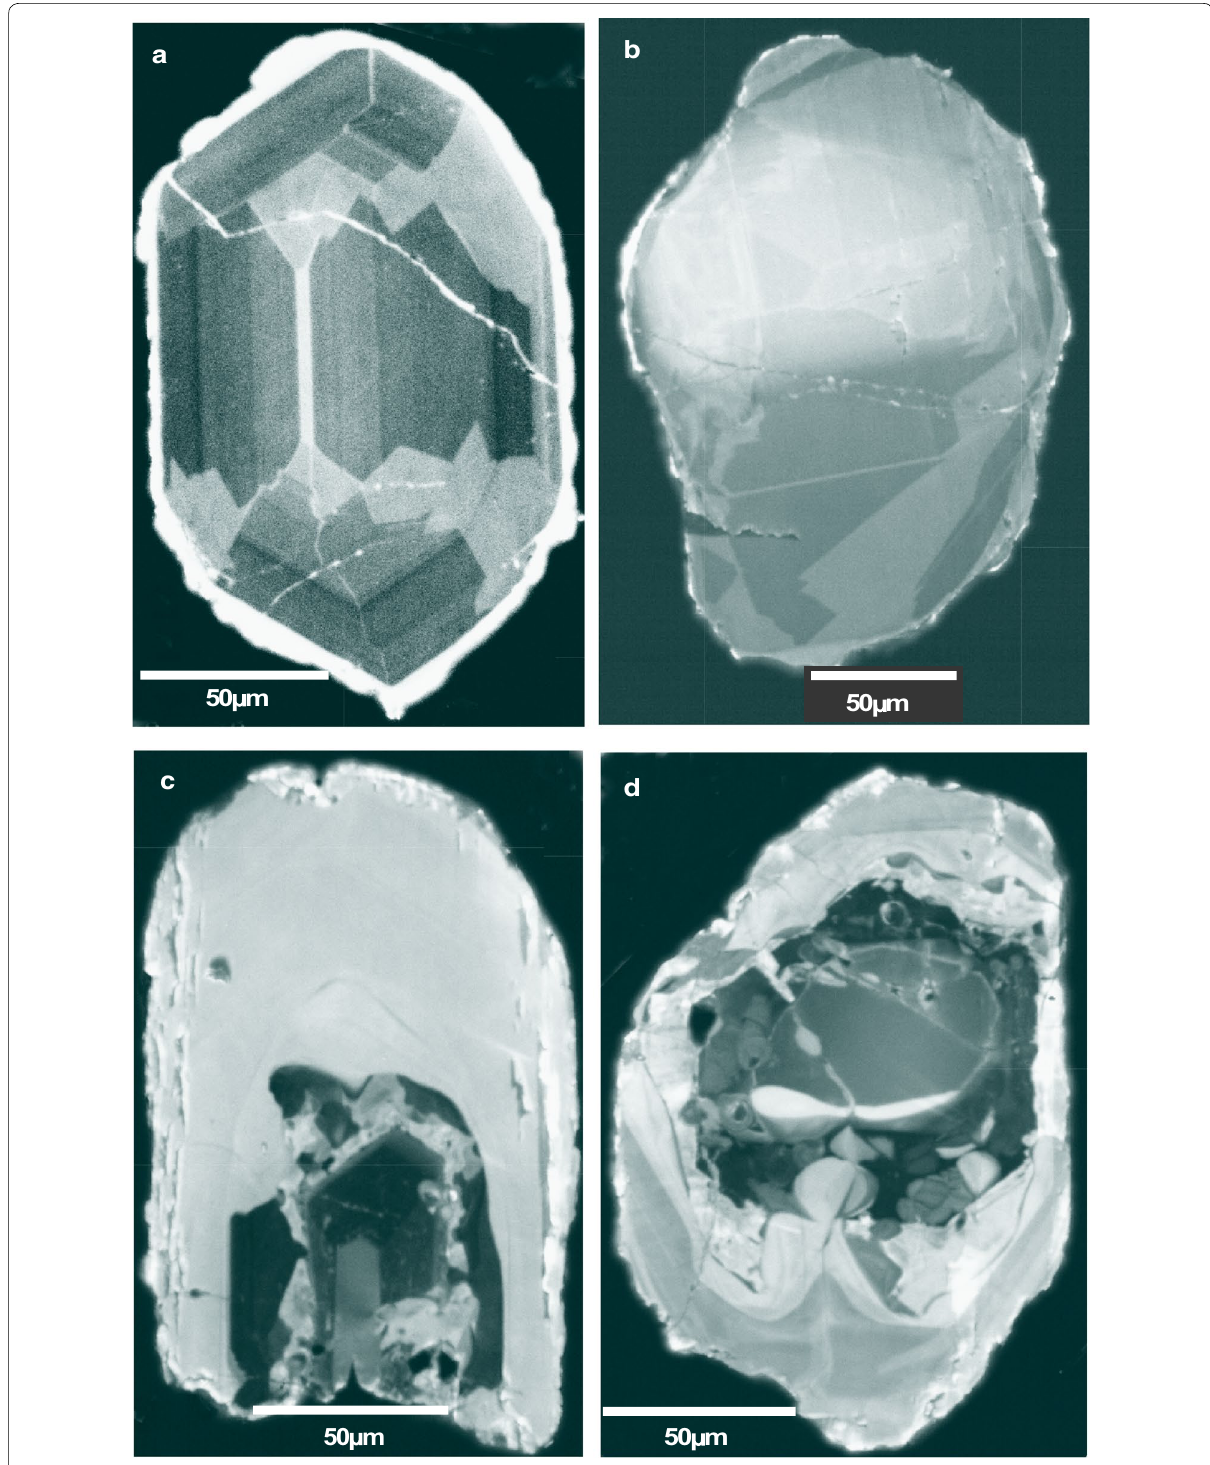
Fig. 7 Cathodoluminescence (CL) images of zircon from eclogite SW9. a Short prism with straight regular zoning, surrounded by a thin rim of CL-bright zircon, the same material also coating fractures at the interior of the grain. b Mosaic textured zircon. c A CL-dark internal domain with regular zoning but also recrystallized CL-bright domains is surrounded by a CL-bright outer zone showing a very faint regular growth zoning. d Complex chaotic texture with a CL-dark internal domain surrounded by CL-bright rim and cut by similar veins, all parts of the grains suggesting extensive metamorphic